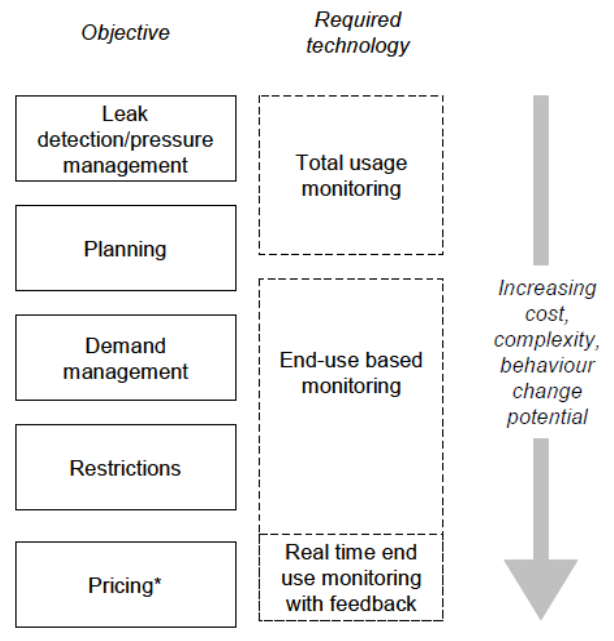
Figure 3. Aligning smart metering technology capability with utility objectives